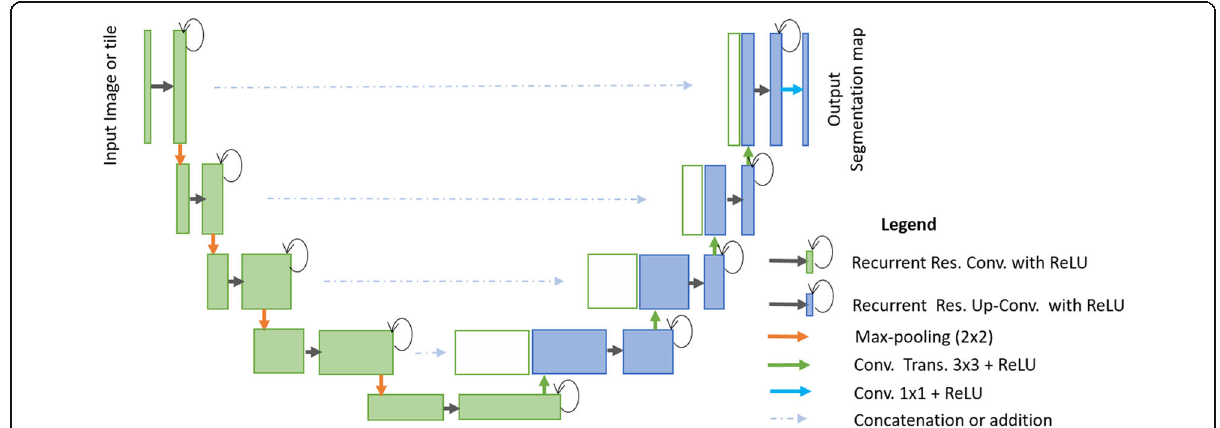
Fig. 4 The end-to-end R2U-Net architecture where the green part refers to the encoding unit, and the blue part refers to the decoding